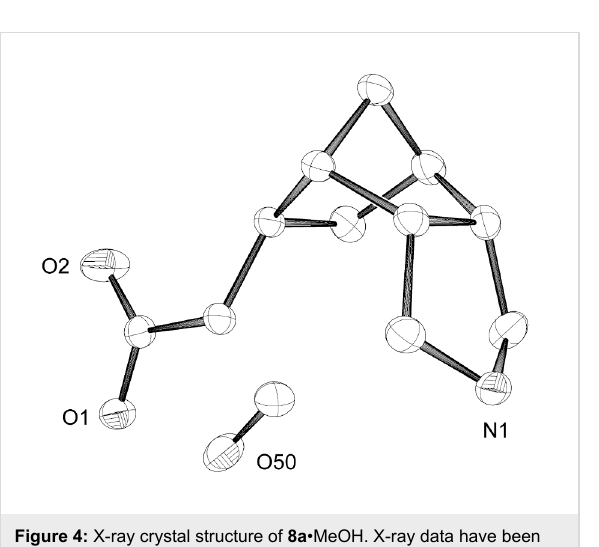
Figure 4: X-ray crystal structure of 8a •MeOH. X-ray data have been deposited with the Cambridge Crystallographic Data Centre (CCDC